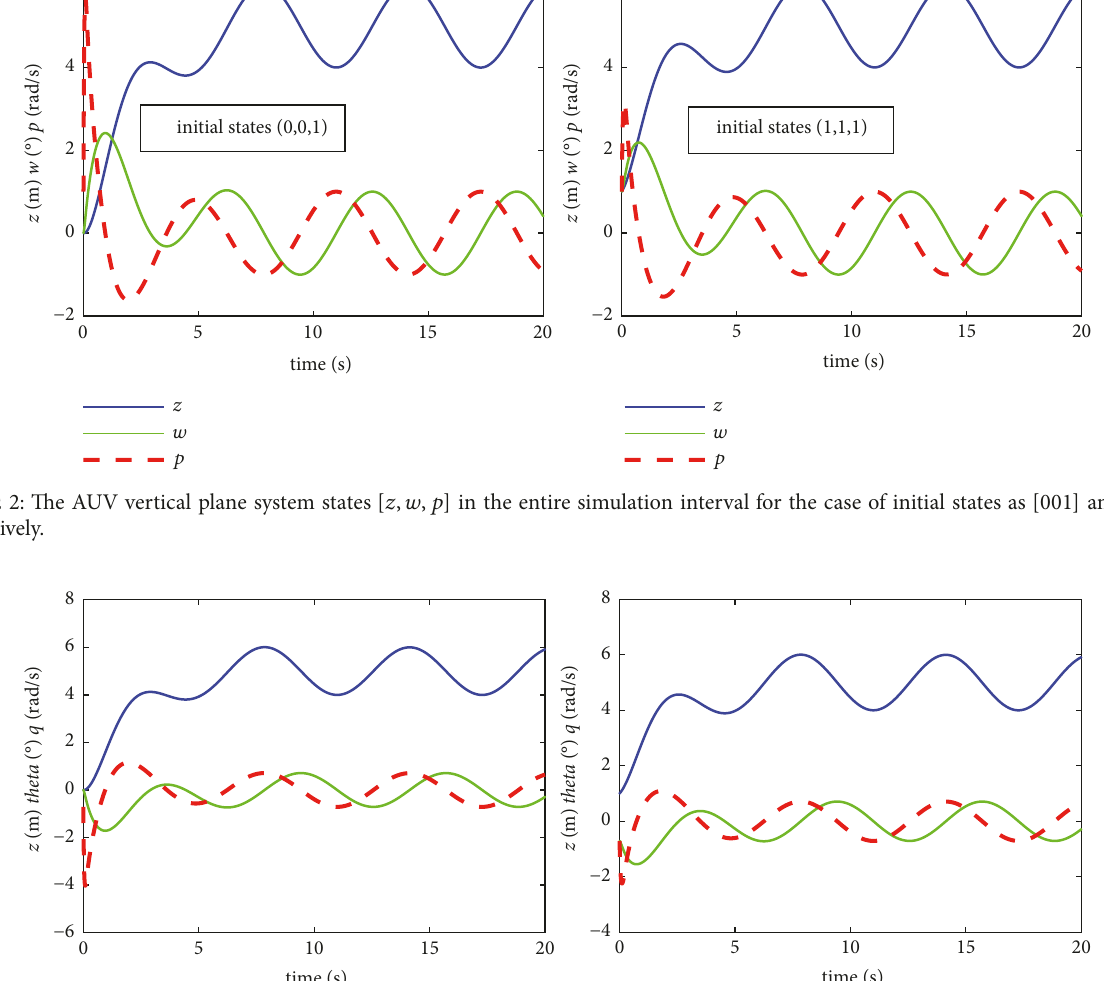
Here, the exponents of (45) are selected as 𝛾 1 = 19/20 ,